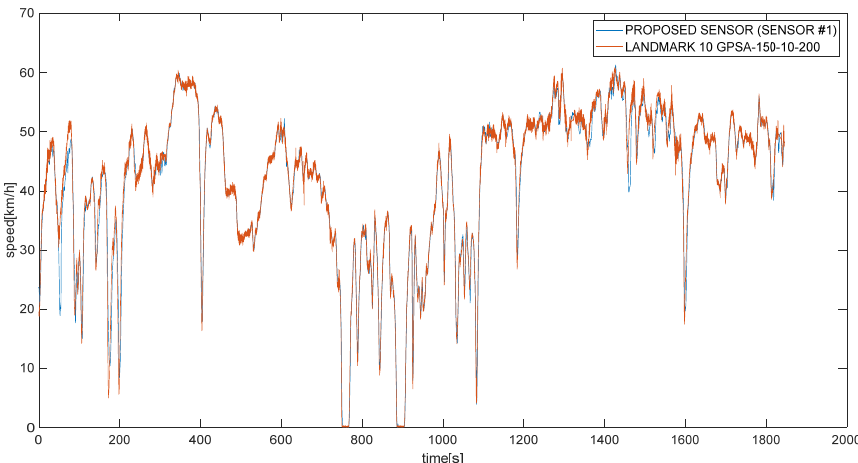
Figure 9. Recorded speed in a test from different instruments placed in the same vehicle: the proposed sensor #1 (blue) and the LandMark 10 GPSA-150-10-200 (orange). Sensors 2021 , 21 , x FOR PEER REVIEW 15 of 23 The comparison between speed values collected by the two devices at the same time sample showed a good correlation (Figure 10). an average total value of only 0.2% between the two speed values was obtained.